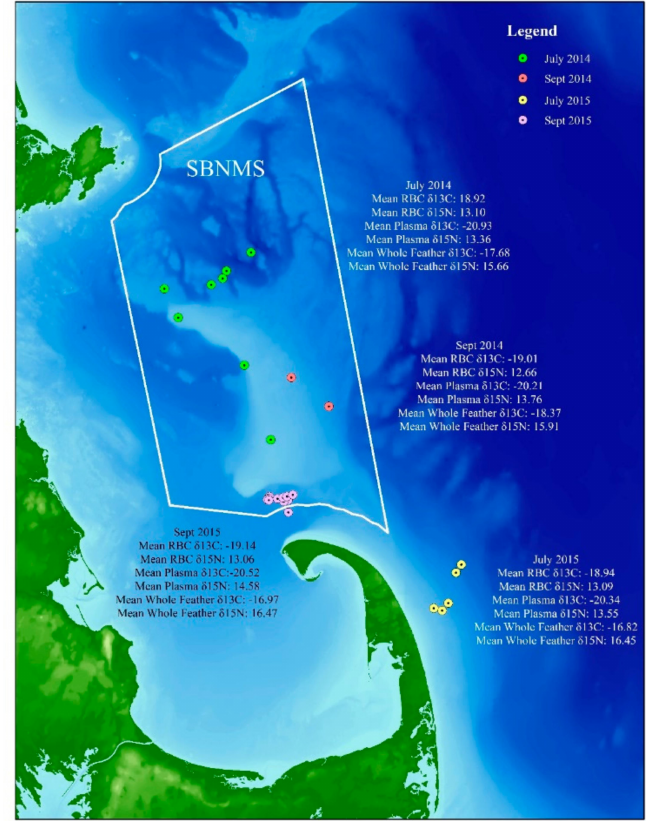
Figure 1. Capture locations of all the great shearwaters from 2014–2015. The points are color coded according to the capture month and year. Mean stable isotope values for the great shearwaters captured at each location are